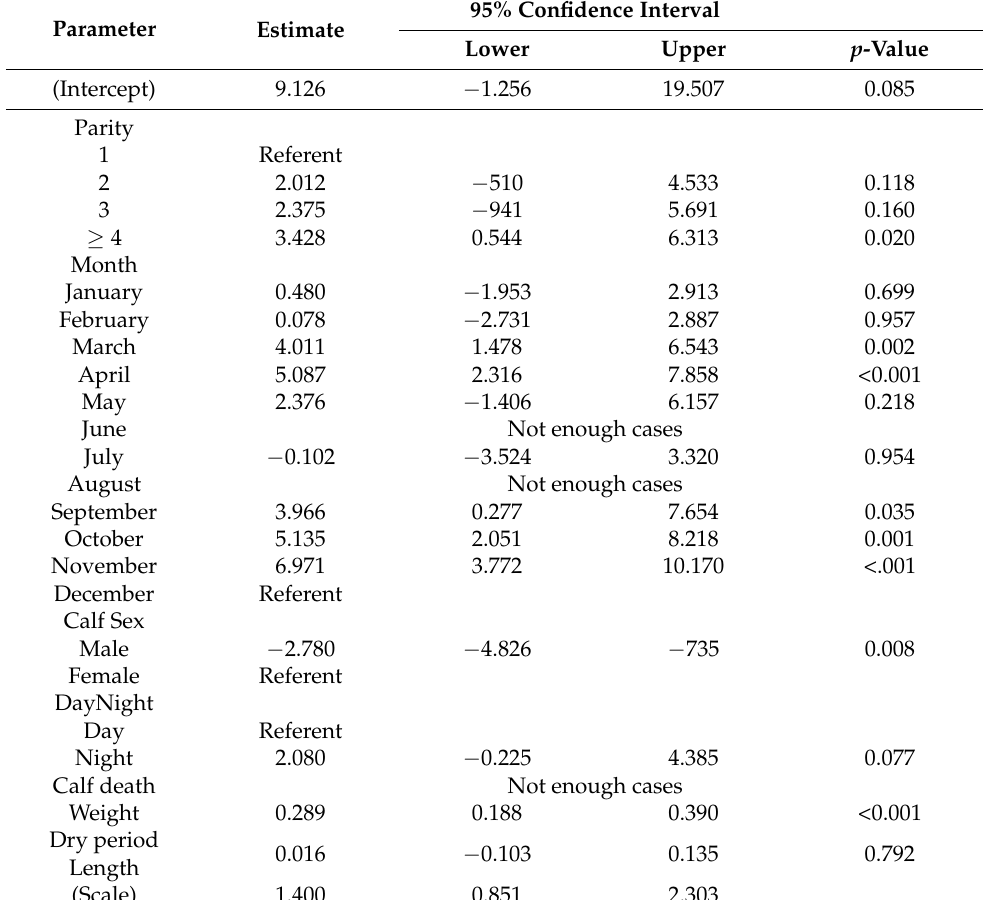
Table 4. Factors affecting colostrum Brix% of dams.